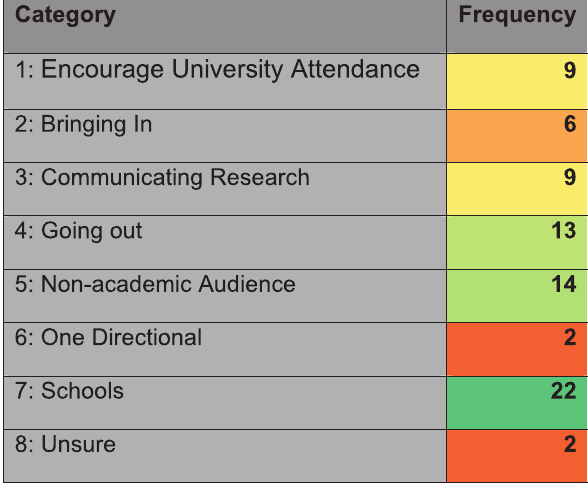
Figure 4. Major categories for ‘definitions of widening participation’ and frequencies; listed in alphabetical order and colour coded according to frequency.